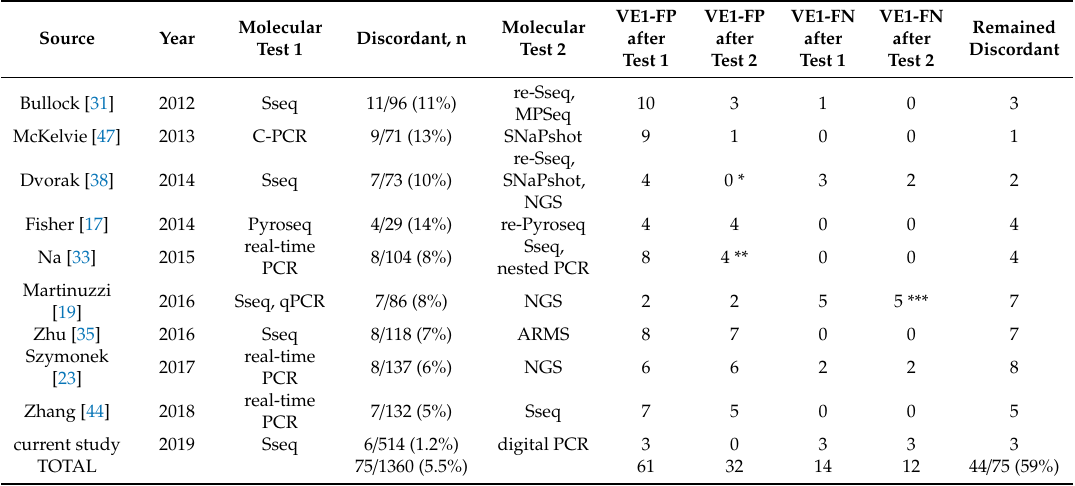
Table 2. Resolving PTC cases discordant between VE1 immunostaining and molecular test. Molecular Source Discordant, Test 1